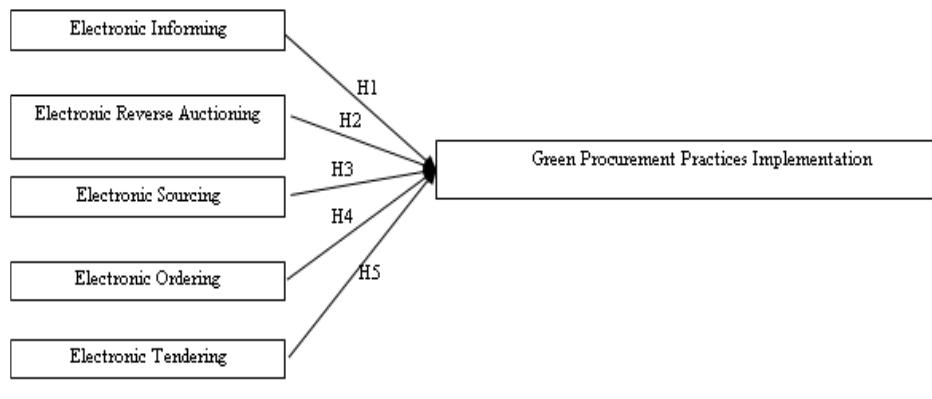
Figure 2. A research framework.